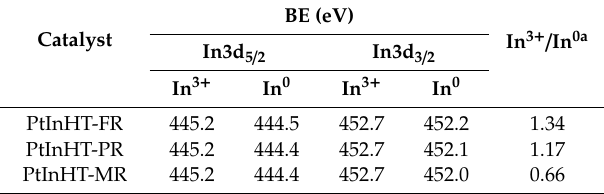
Figure 5. XPS spectra of the In 3D region of reduced catalysts. Table 3. XPS results of reduced catalysts.